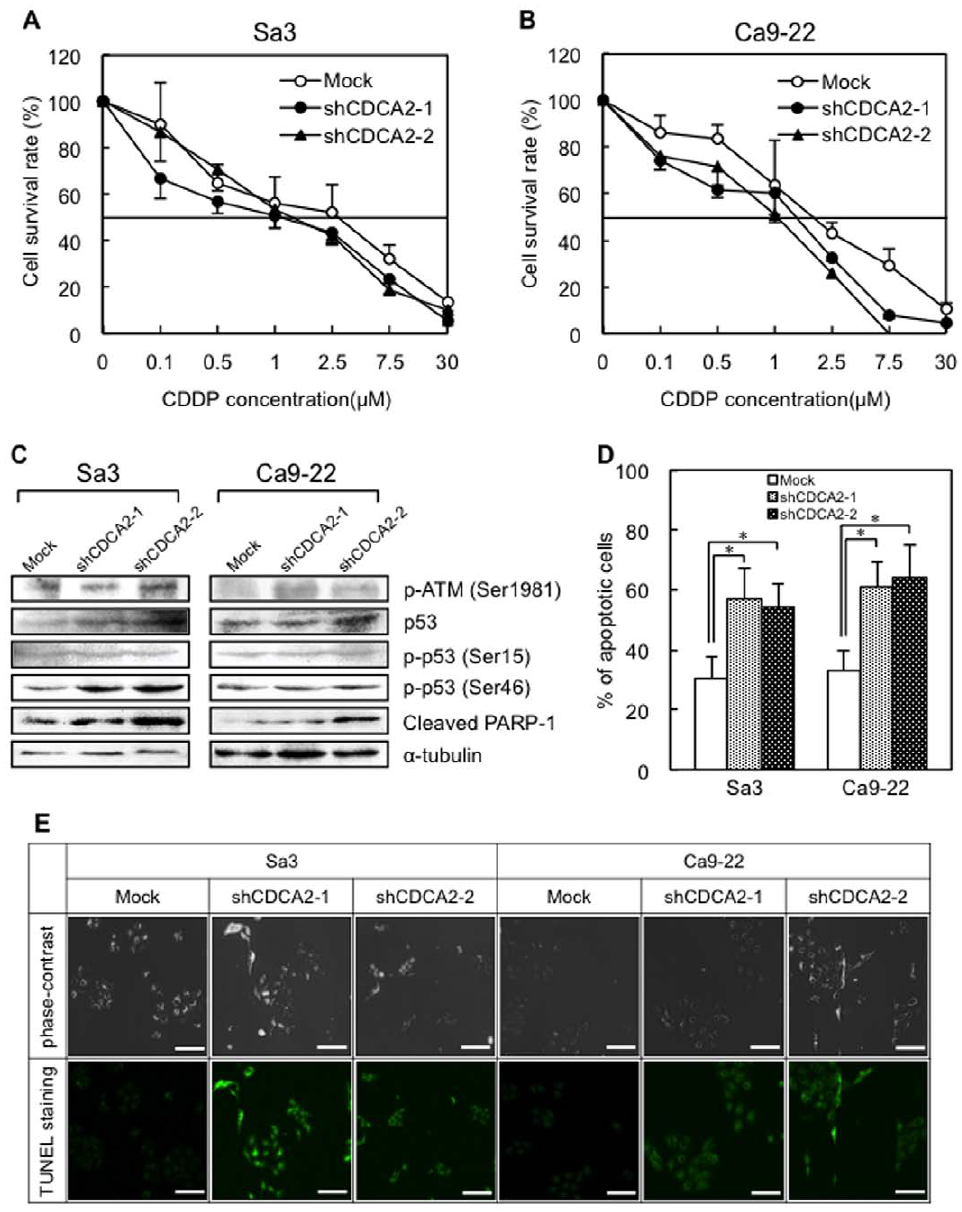
Figure 4. Antitumor activity in shCDCA2-transfected cells. Sensitivity of shCDCA2-transfected Sa3 ( A ) and Ca9-22 ( B ) cells to CDDP. The IC50 values for the shCDCA2-transfected cells were Sa3 (Mock: 2.78 m M, shCDCA2-1: 1.12 m M, shCDCA2-2: 1.31 m M) and Ca9-22 (Mock: 1.82 m M, shCDCA2- 1: 1.39 m M, shCDCA2-2: 1.04 m M), respectively. ( C ) Western blot analysis of p-ATM, p53, p-p53 (Ser15), p-p53 (Ser46), and cleaved PARP-1 in the shCDCA2- and mock-transfected cells after CDDP treatment. p -ATM, p-p53 (Ser46), and cleaved PARP-1 protein expression is up-regulated in the shCDCA2-transfected cells compared with the mock-transfected cells; the p53 and p-p53 (Ser15) level is unchanged. Densitometric protein data are shown in Figure S3A and B. ( D ) Quantitative analysis using the TUNEL assay. The number of dead cells per field of view after CDDP treatment is significantly increased in the shCDCA2-transfected cells compared with the mock-transfected cells (* P , 0.05, Mann-Whitney’s U test). ( E ) Representative results of the TUNEL assay (Scale bars, 30 m m.). More apoptotic cells are clearly seen in the shCDCA2 transfected cells than in the mock transfected cells. and normal oral tissues ranged from 20.0 to 190.0 (median, 95.0), and 2.5 to 90.0 (median, 30.0), respectively. The IHC scores in